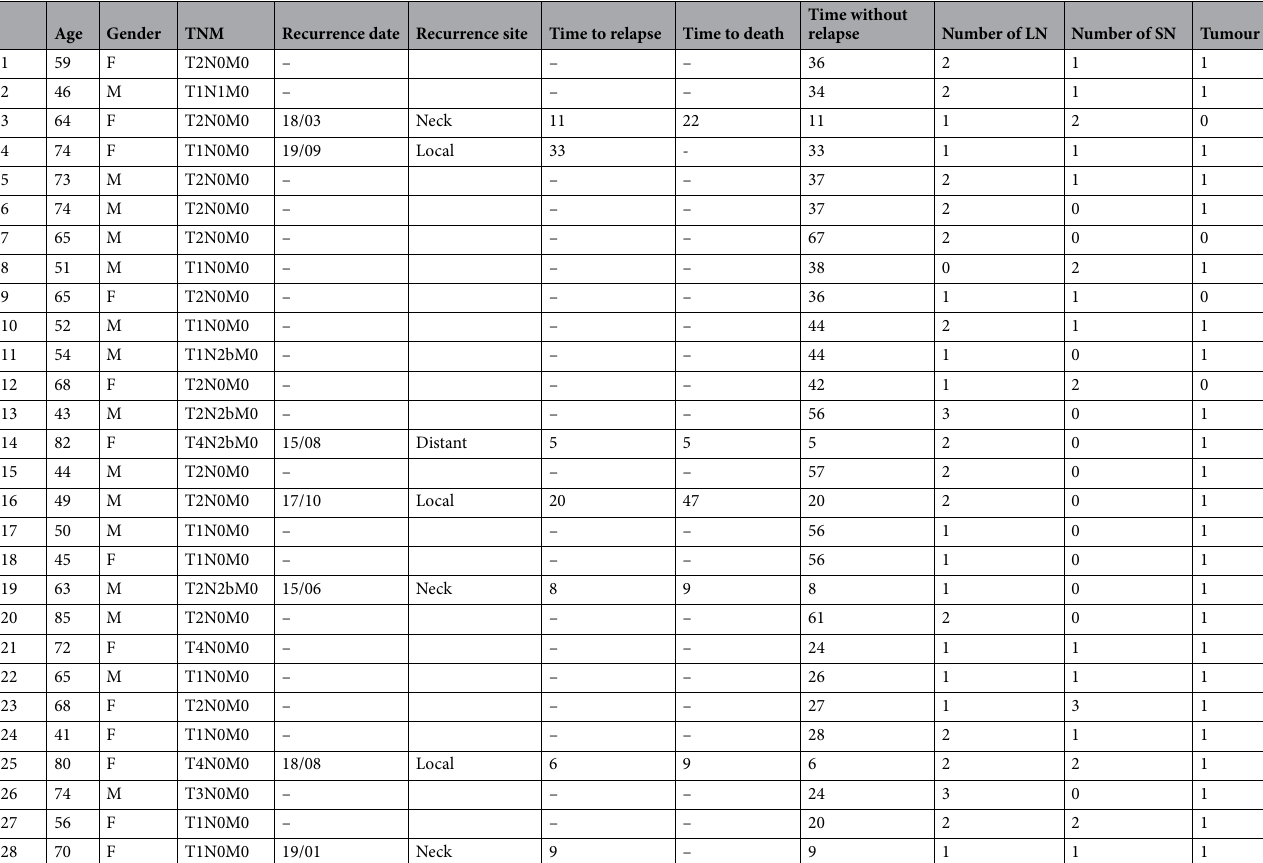
Table 1. Clinical data of enrolled